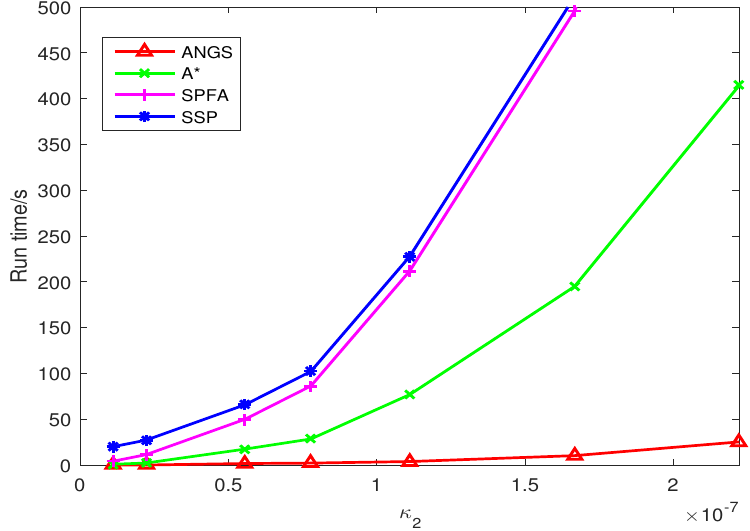
Figure 11. The comparison of average running